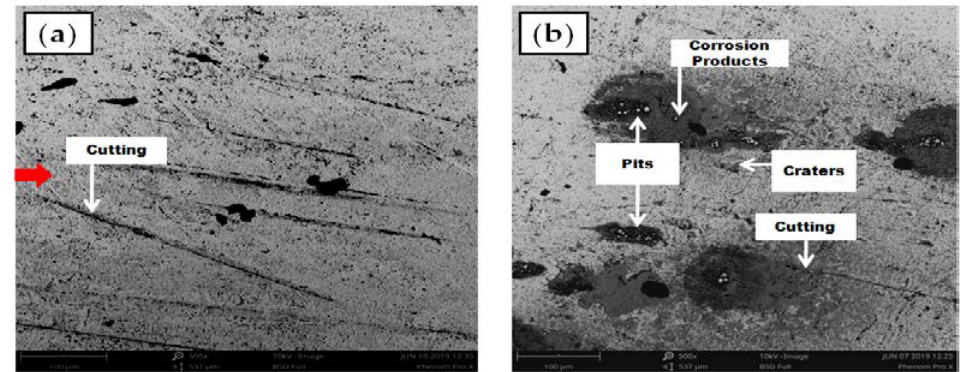
Figure 18. Microscopic images of 90-degree elbow BH section after the test at 2 m/s flow velocity ( a ) inlet ( b ) outlet.